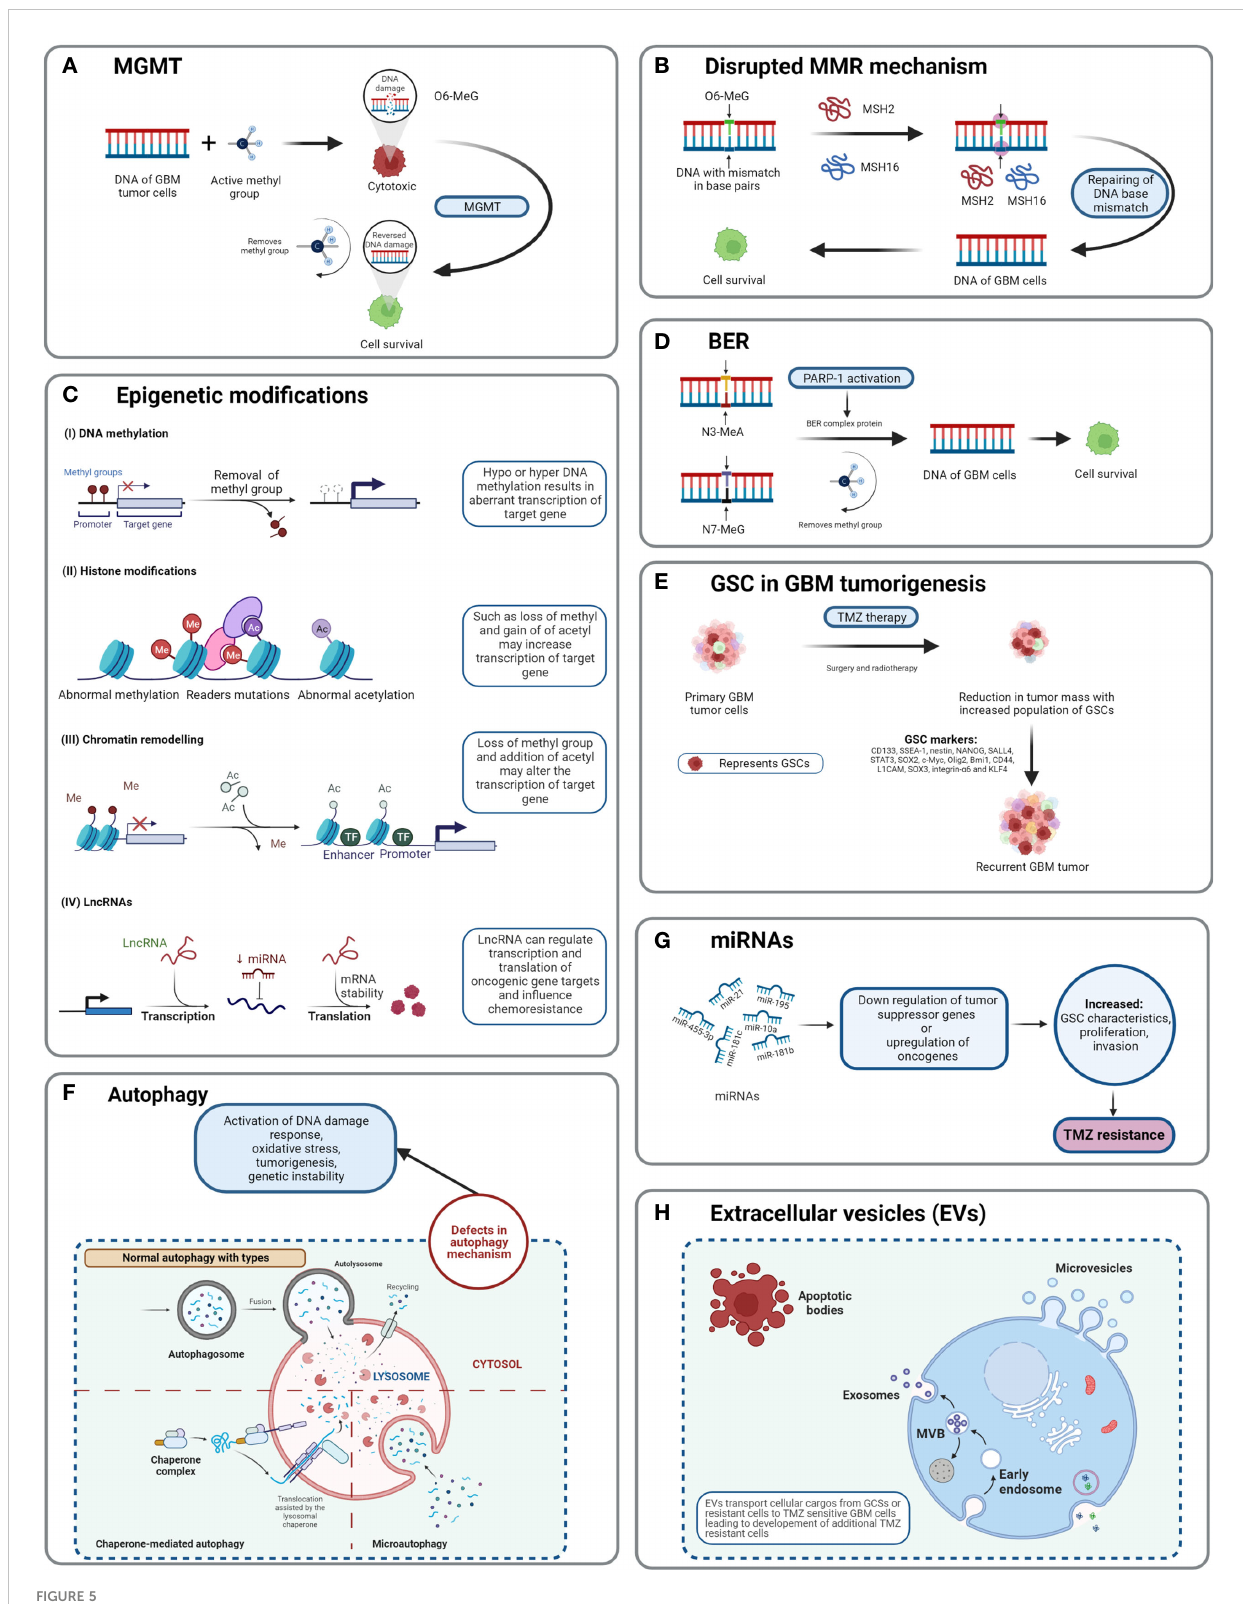
FIGURE 5 Detailed TMZ resistance mechanism in GBM. (A) Enzyme MGMT reverses the methylation O6-MeG by removing a methyl group, leading to increased cellular survival of GBM cells (50). (B) Disruption in the MMR mechanism repairs the mismatch between DNA bases (51). (C) Major epigenetic alterations include DNA methylation, histone modi fi cations, chromatin remodeling, and lncRNAs (52). (D) The BER system removes or repairs DNA nucleotides. N3-MeA and N7-MeG are repaired by the BER mechanism (2). (E) GCSs are diverse and lead to generation of TMZ-resistant cells with self-renewal capabilities (52). (F) Defects in normal autophagy contribute to resistance development against TMZ (52). (G) The expression levels of miRNAs alter gene regulation, causing TMZ resistance (52). (H) Extracellular vesicles (EVs) are capable of regulating TMZ resistance related to biological material and cellular cargo